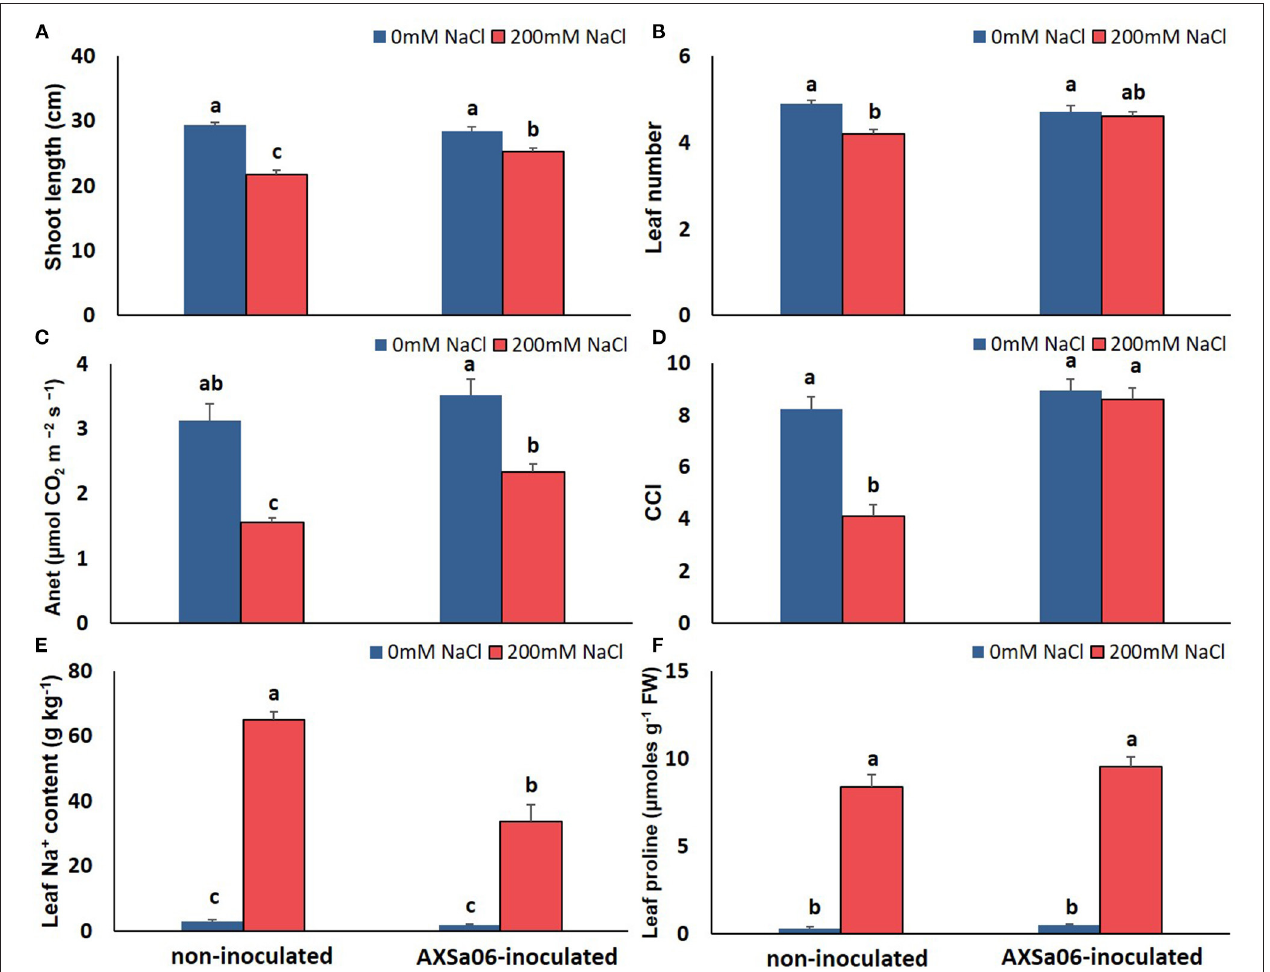
FIGURE 1 | Effect of AXSa06 ( Pseudomonas oryzihabitans ) seed inoculation on tomato seedlings treated with 200mM NaCl for 7 days: (A) shoot length (cm); (B) leaf number; (C) net photosynthesis (Anet, µ mol CO 2 m − 2 s − 1 ); (D) chlorophyll content index; (E) leaf Na + content (g kg − 1 ); (F) leaf proline content ( µ mols g − 1 FW). Data are means ± standard error. Different letters indicate statistically significant differences between treatments based on Duncan’s multiple range test ( P <